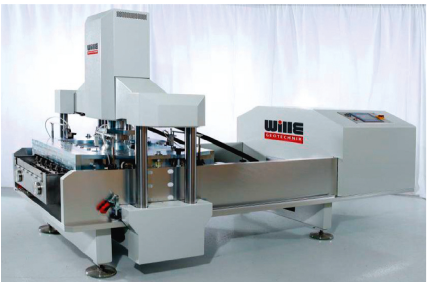
Figure 3: The large-frame shear device.